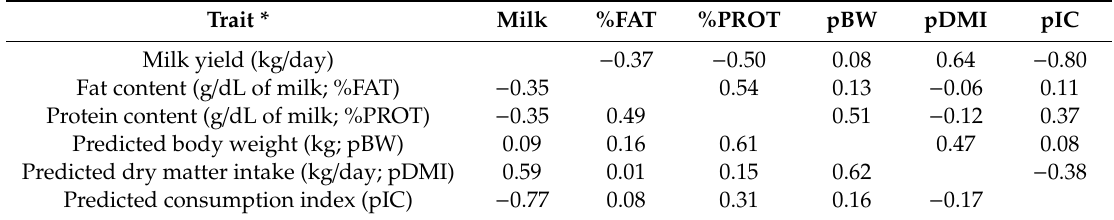
Table 2. Correlation coefficients observed between studied traits in first (below the diagonal) and second lactation (above the diagonal).